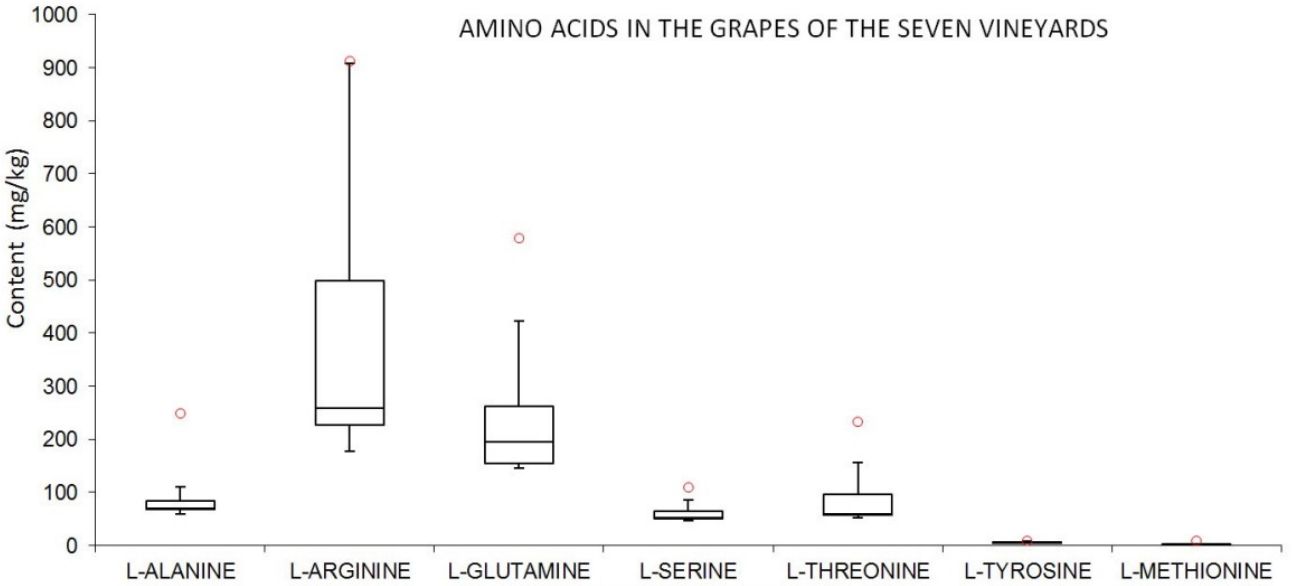
Figure 11. Biochemical analysis of the grapes found the amounts of amino acid to be entirely characteristic of vineyard V1, as highlighted by all the red circles (statistical outliers). Note the amount of L-arginine in V1, which is also a source of nitrogen and indicates this element’s availability for metabolism. The red circles represent the maximum statistical